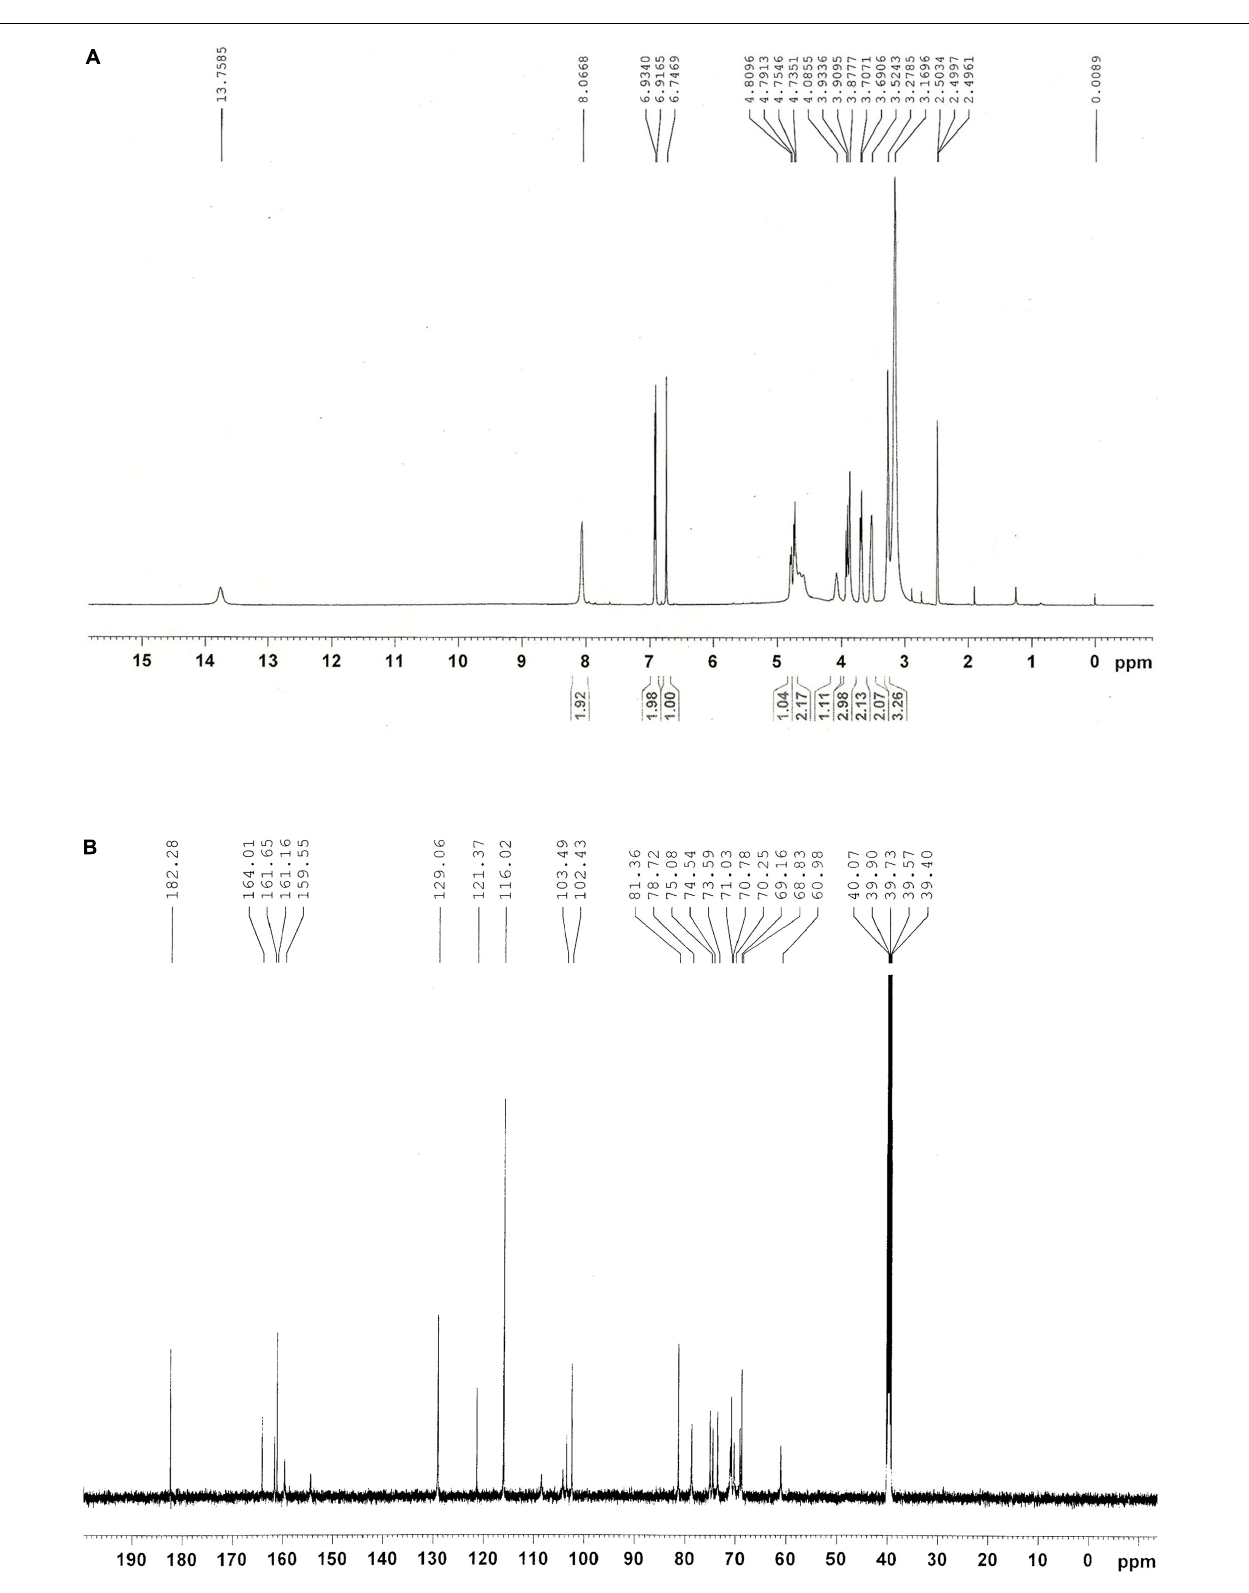
Frontiers in Plant Science |